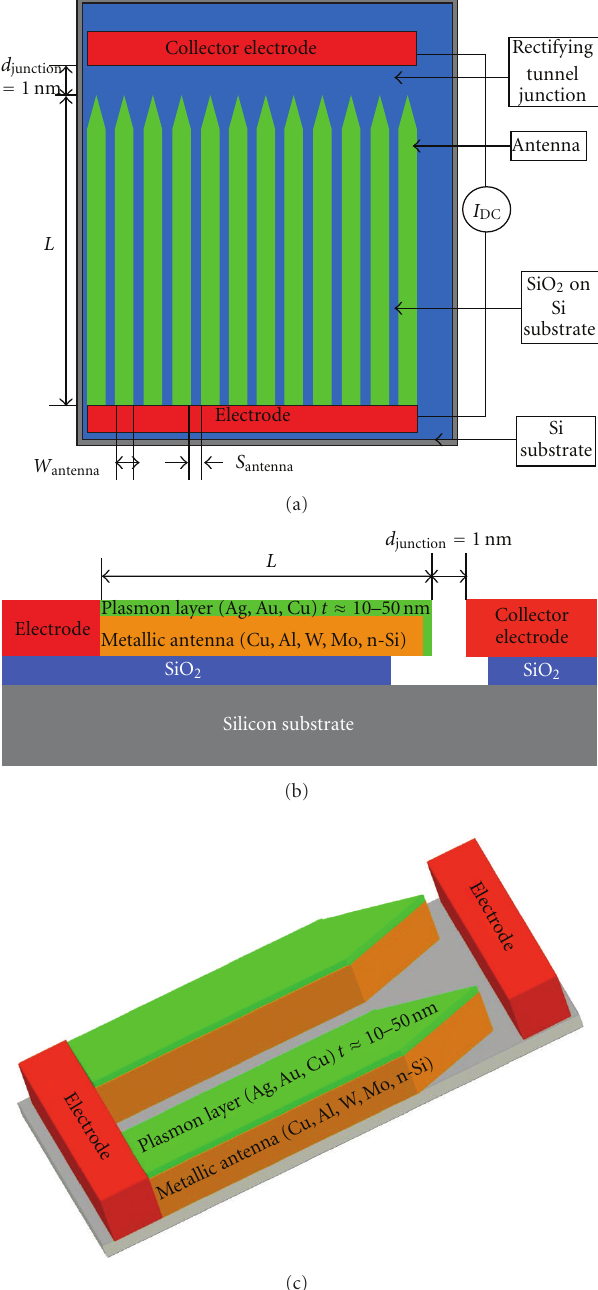
Figure 18: Schematic of proposed rectenna device. (a) Top view, (b) side view, and (c) 3D